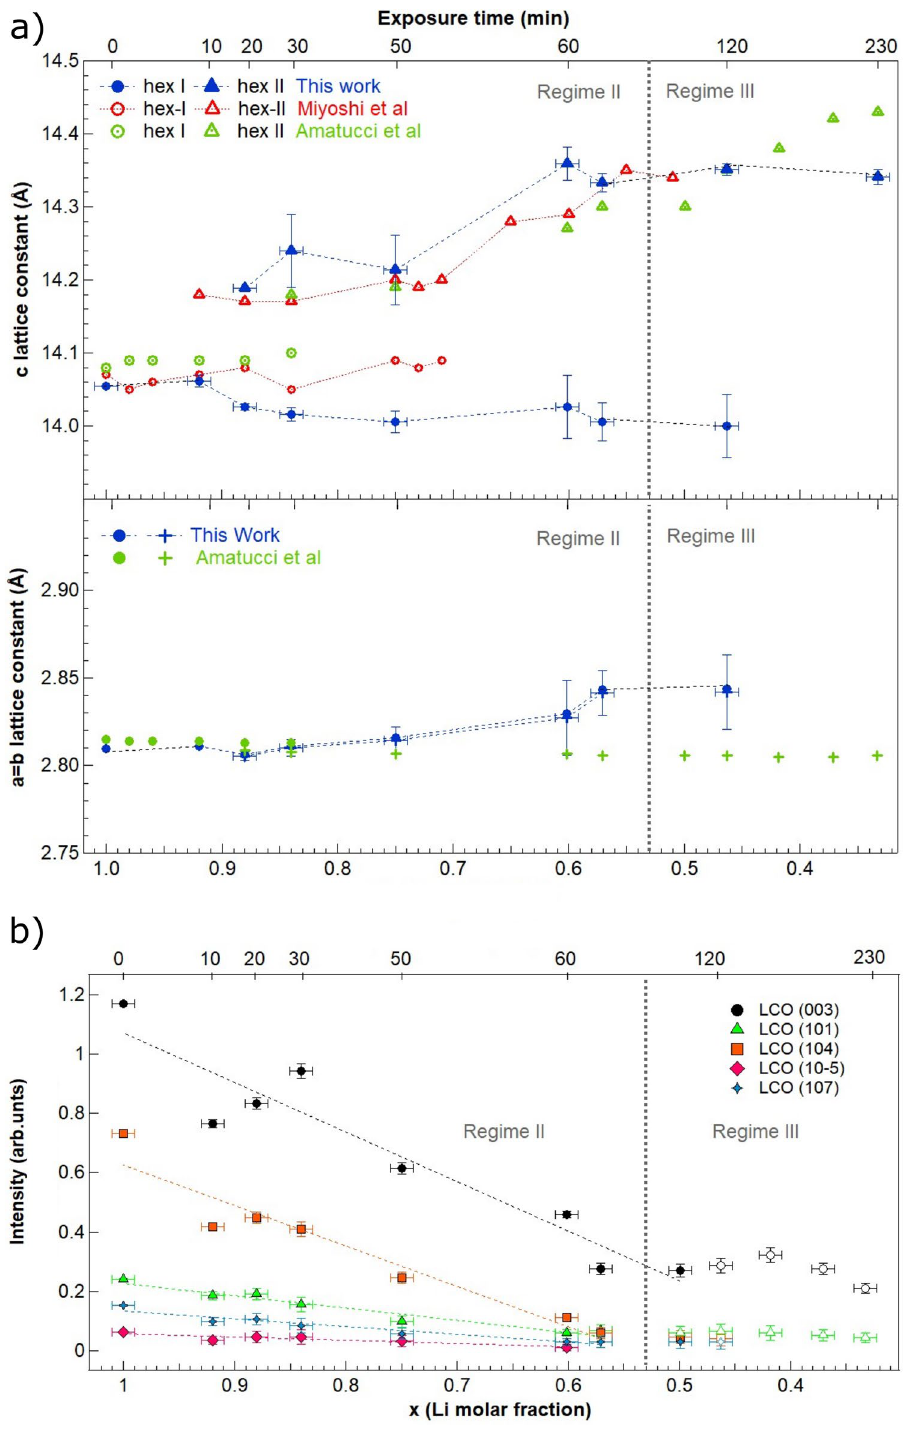
Figure 6. Dependences of ( a ) lattice parameter c and a for Li x CoO 2 and ( b ) the intensities of X-ray reflections on the exposure time at 10 –2 M concentration (top axis) and Li molar fraction (bottom axis). The appearance of c and a values are compared to literature values reported in Ref. 17, 24